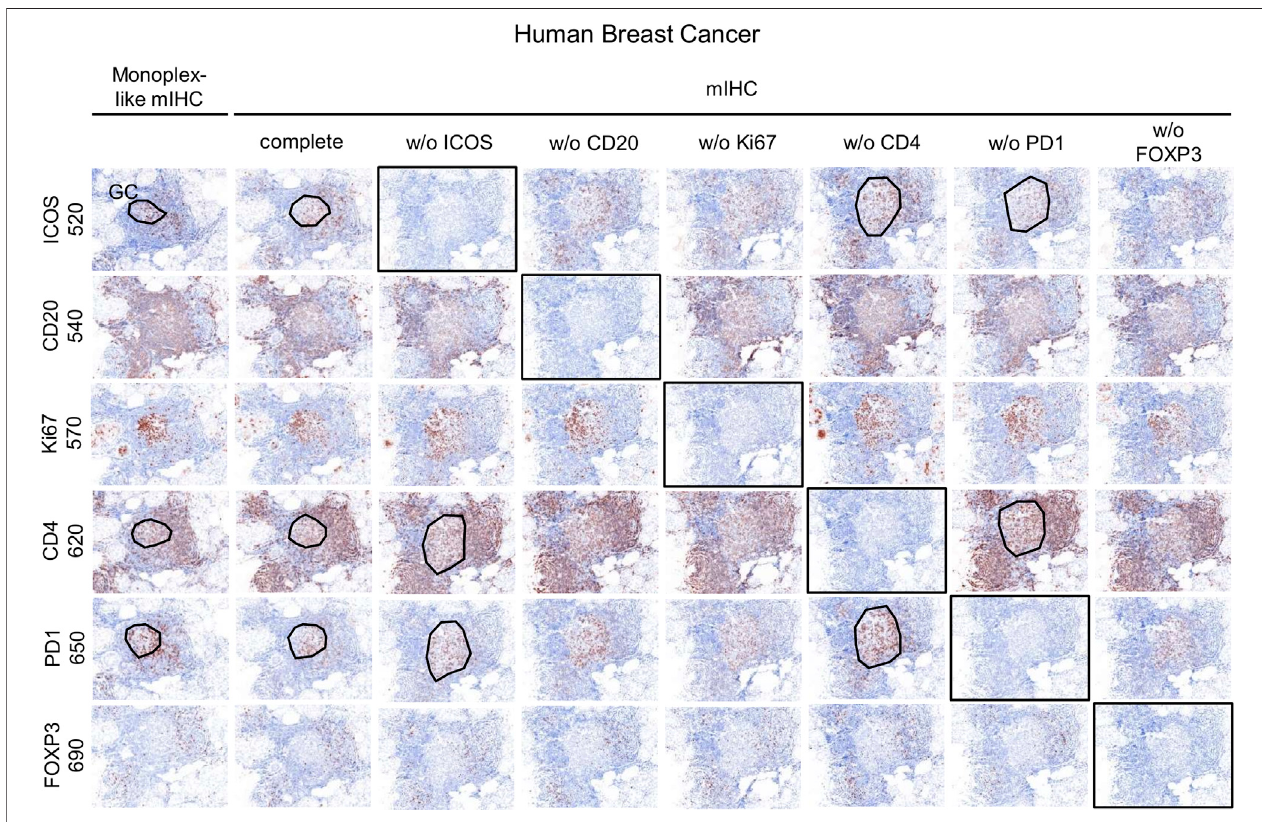
FIGURE 6 | Evaluation of the mIHC using drop controls. Simulated DAB IHC images of monoplex, mIHC, and drop control slides stained on consecutive FFPE breast tumor